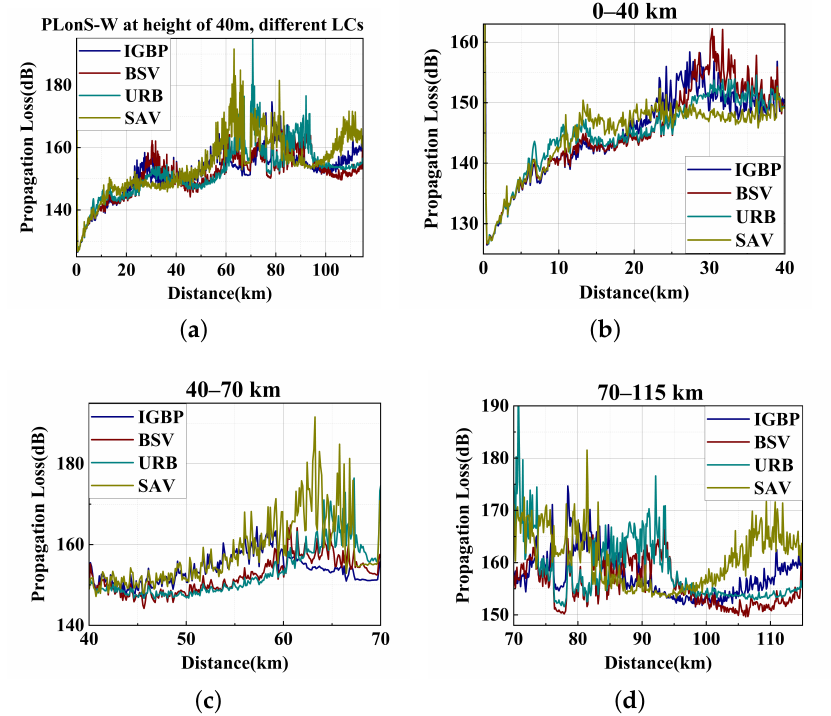
Figure 22. The propagation loss using the improved TWPE at a height of 40 m using different land covers, on Shanghai–Wuxi. ( a ) PL on S–W at different LCs at an antenna height of 40 m. ( b ) PL on S–W at a range of 20–40 km at different LCs. ( c ) PL on S–W at a range of 40–70 km at different LCs. ( d ) PL on S–W at a range of 70–115 km at different